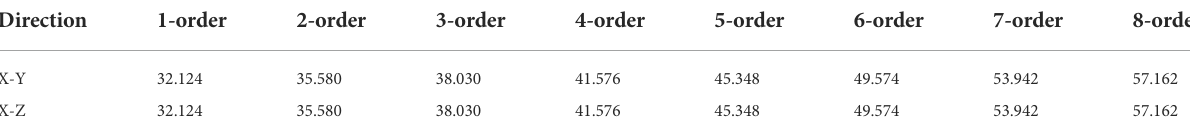
TABLE 3 Frequency of